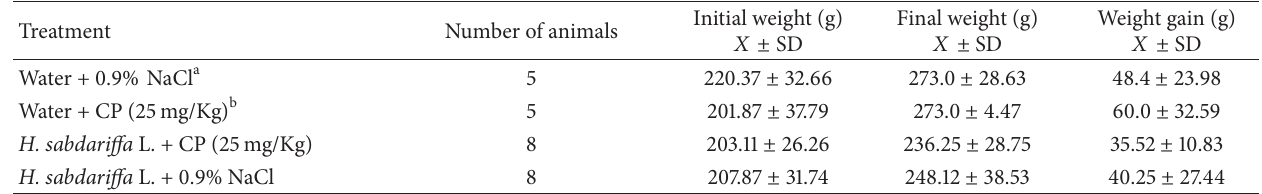
Control; b Cyclophosphamide. Mean and standard